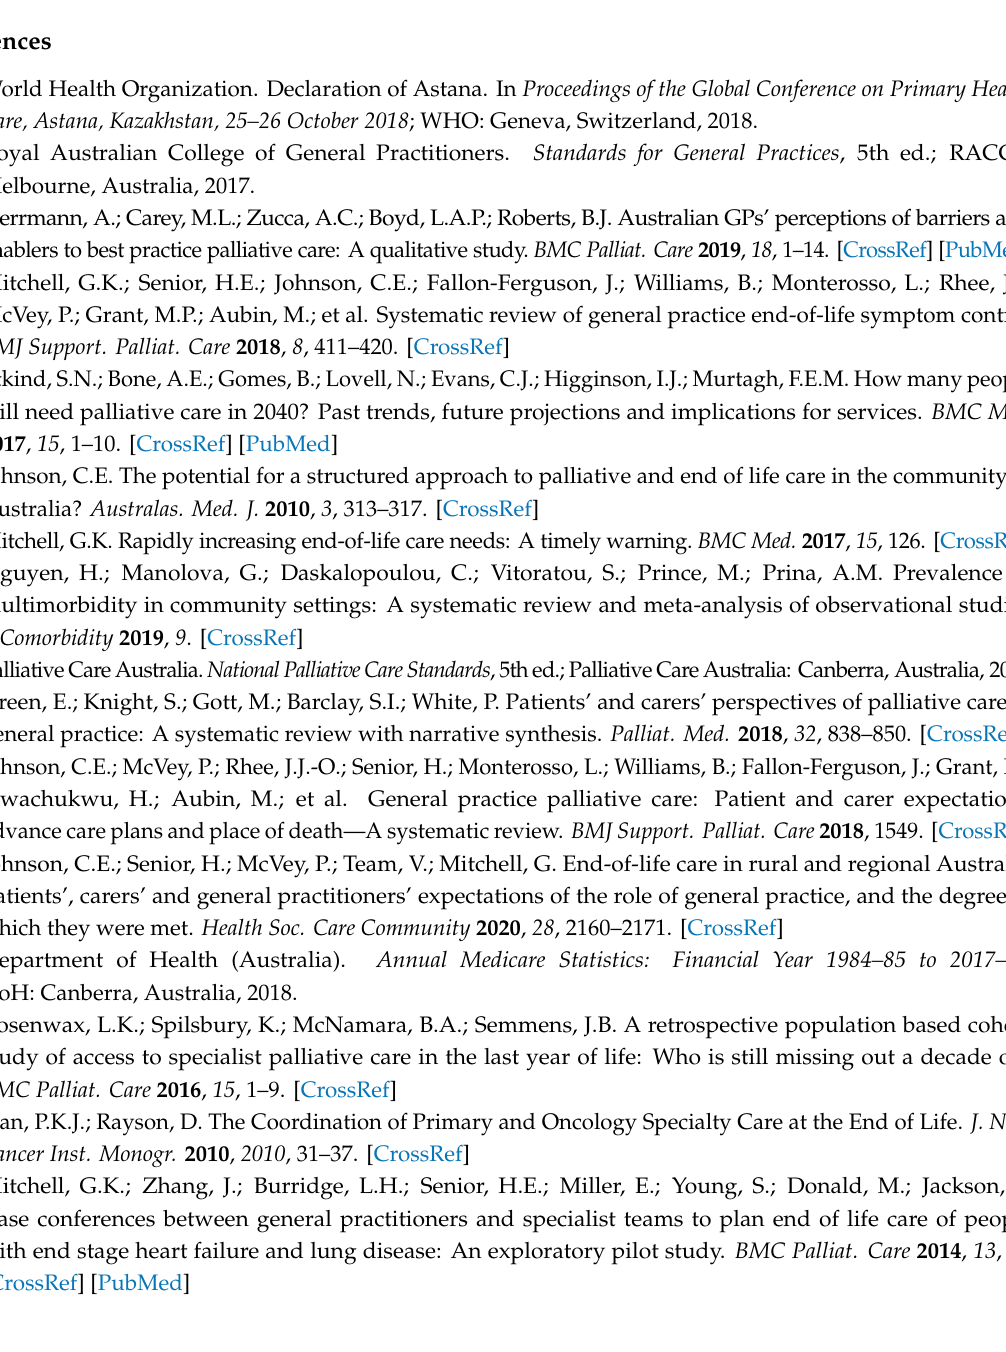
Table S1: Ovid MEDLINE search strategy, Table S2: Directive guideline content mapped to PEPSI-COLA framework, Table S3: Other considerations not accommodated by PEPSI-COLA